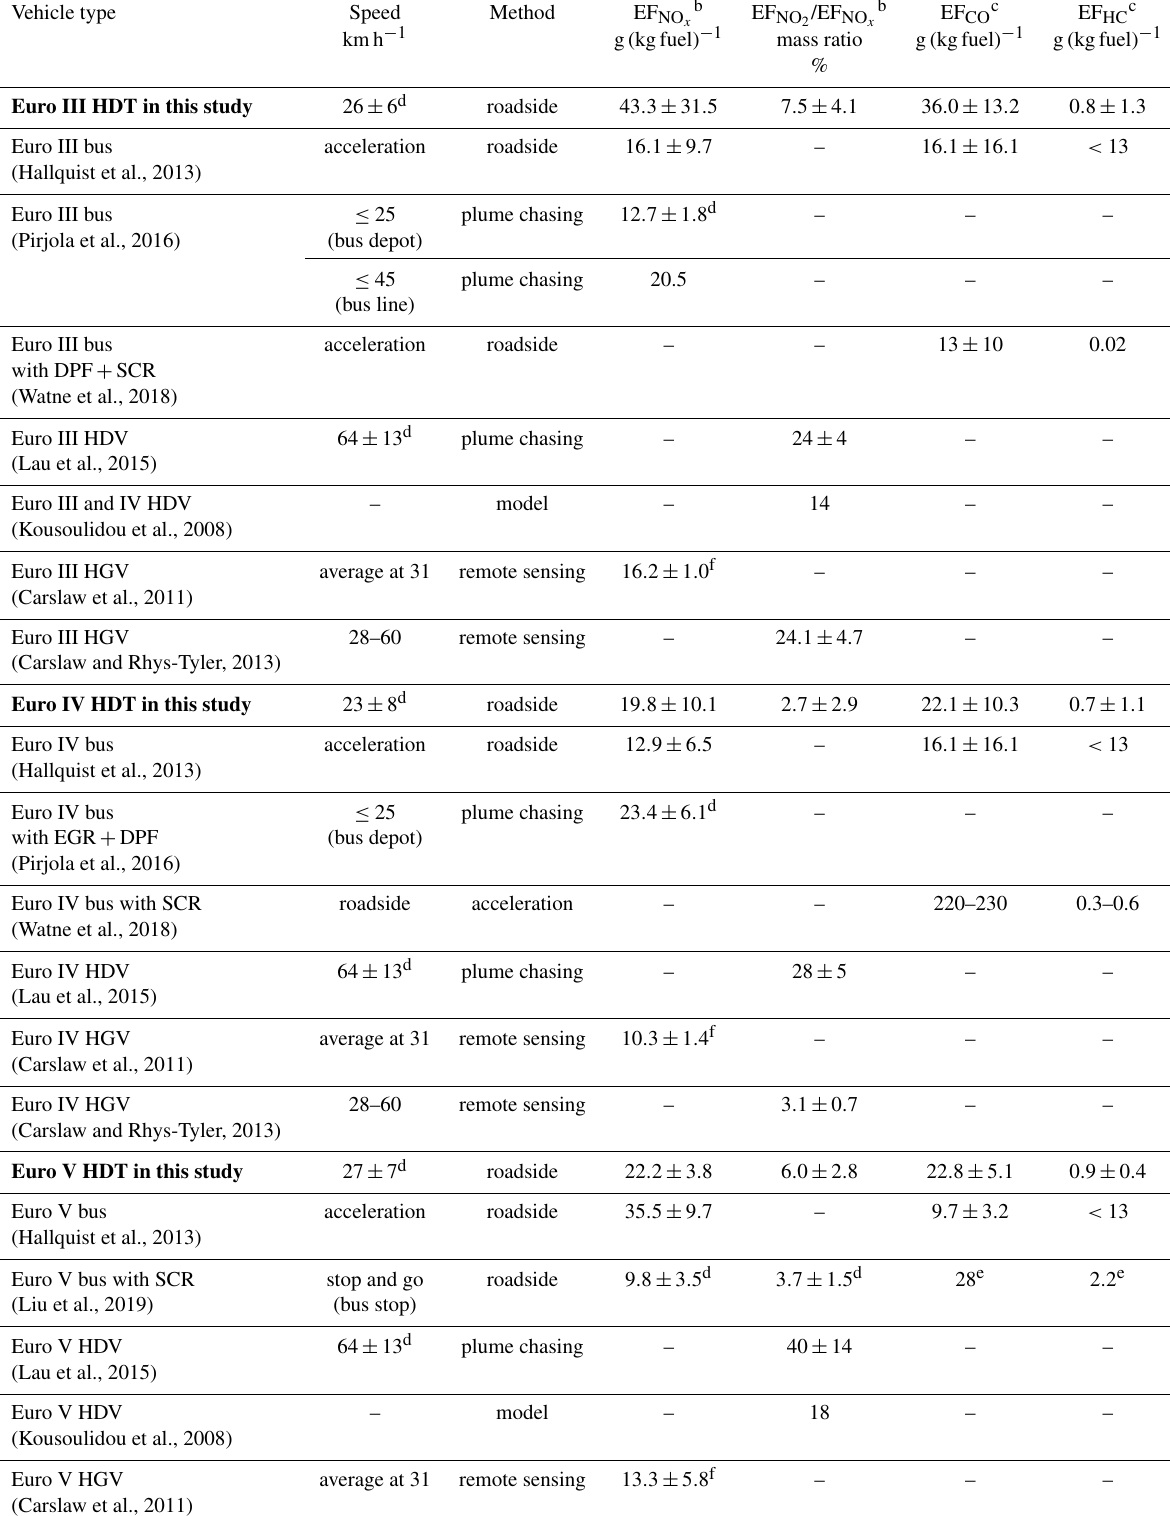
Table 2. Comparison of the average emission data a for NO x , NO 2 /NO x , CO, and HC from the present study with literature data. Bold font was used for better illustration of different Euro